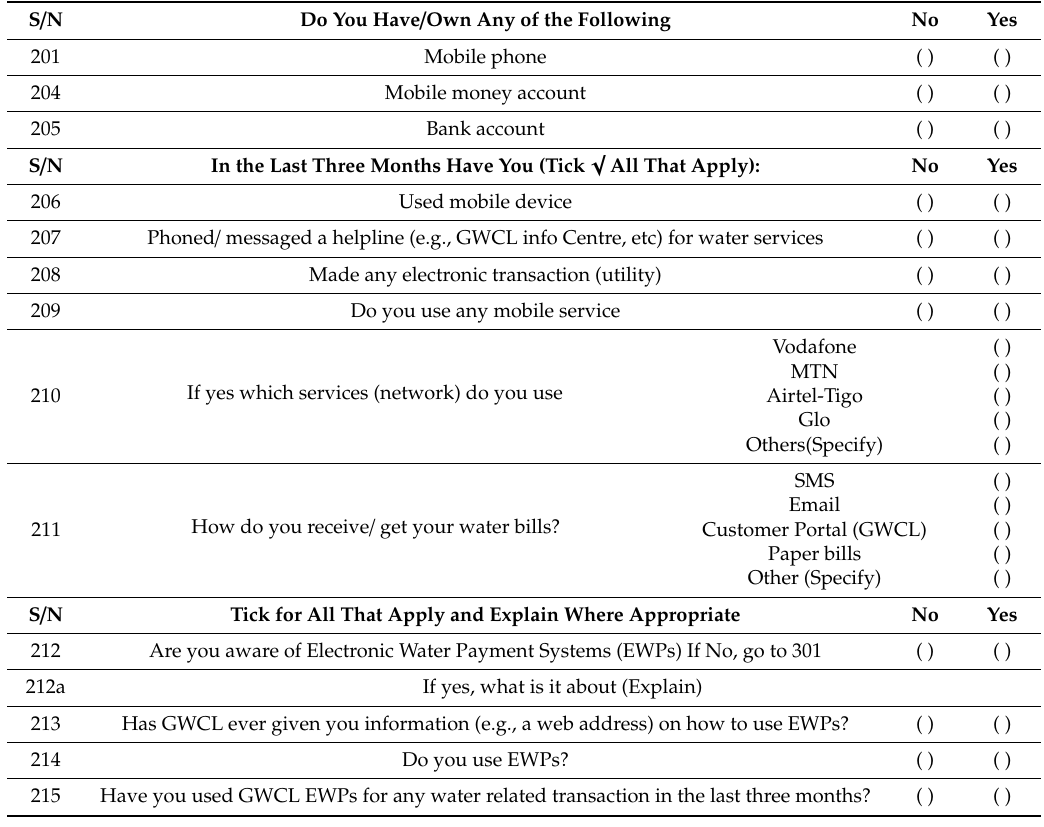
Table A3. EWP and GWCL